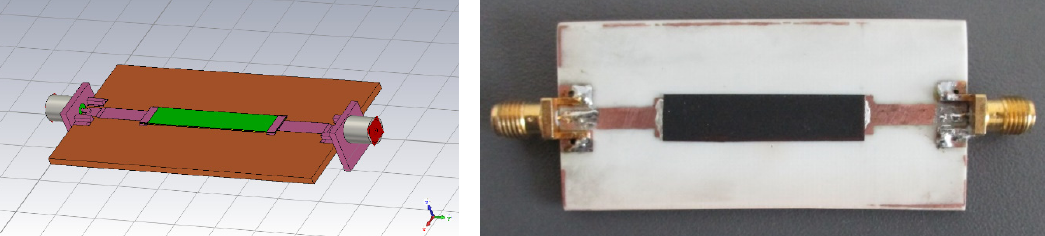
Figure 9. CST studio model of (left) and the real microstrip line (right) made from polymer composite comprising carbon nanotubes and polymer matrix for effective conductivity measurement.